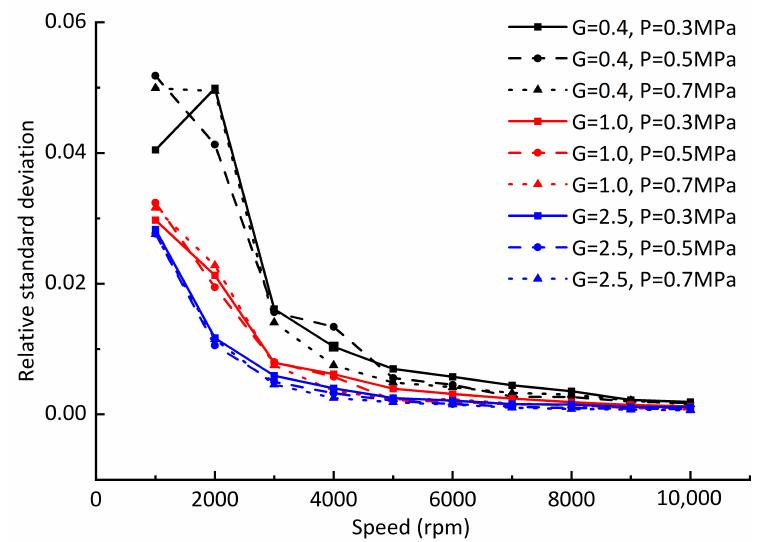
Figure 13. Relative standard deviation of dynamic equilibrium position offsets (gas film gap C 1 = 10 µ